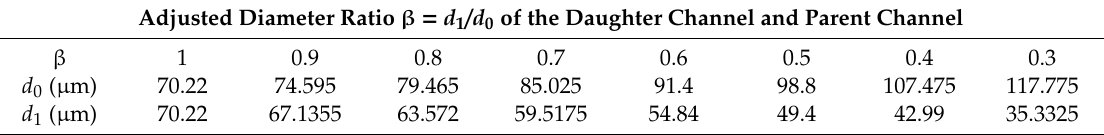
Figure 1. A schematic figure of the Y-shaped rectangular microchannel heat sink (MCHS). Table 1. Cross-sectional dimensions of the Y-shaped circular microchannels.